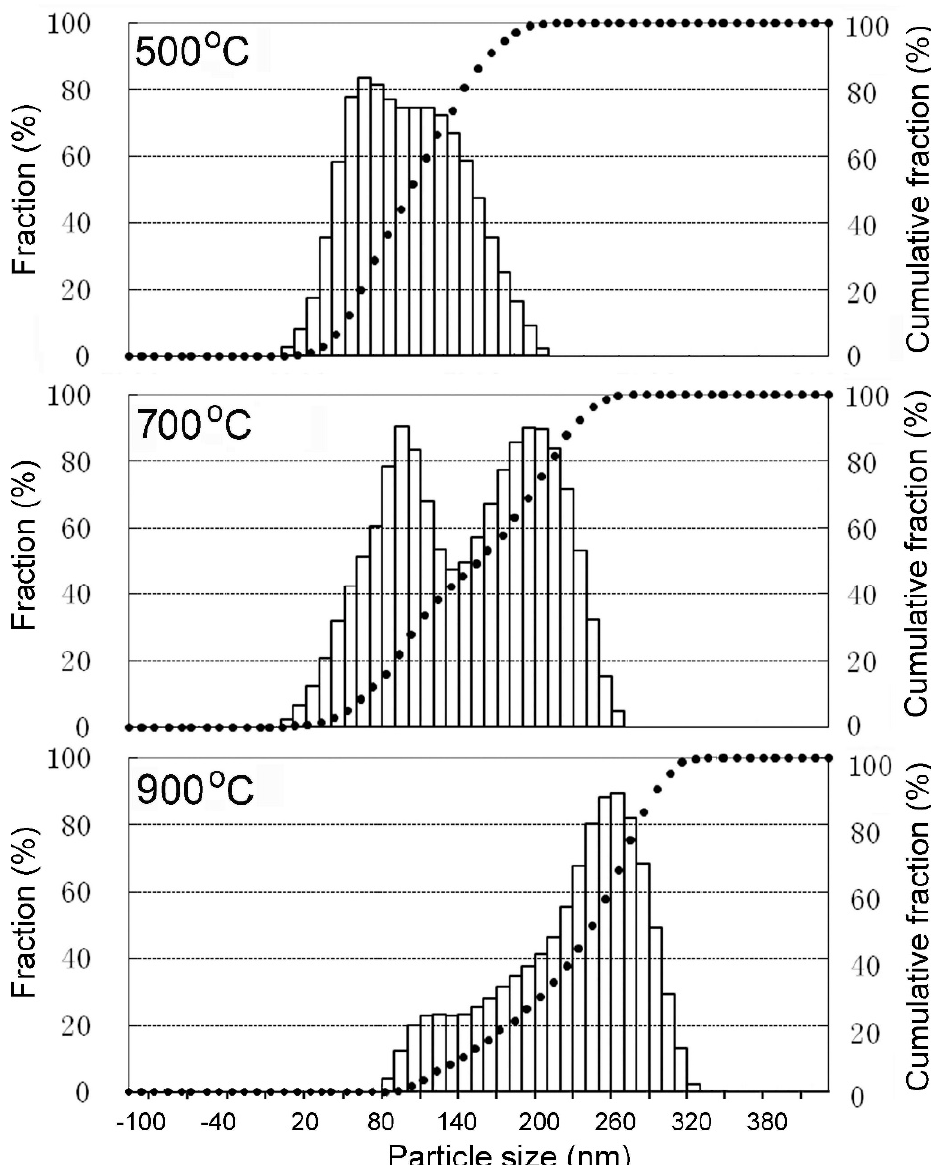
Figure 7. Particle size distribution of the powder that was reduced at the temperature range of 500–900 °C.